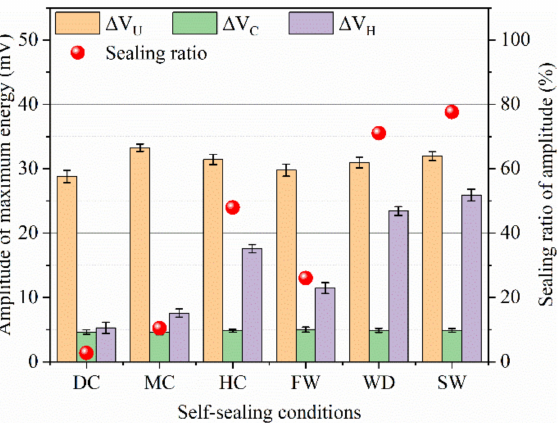
Figure 11. Self-sealing ratios based on the maximum amplitude of ultrasonic